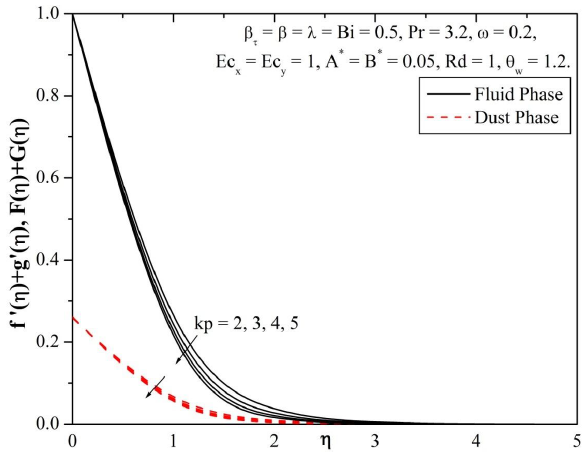
Fig. 3: Dimensionless profiles of v , v p velocity components for different values of k p